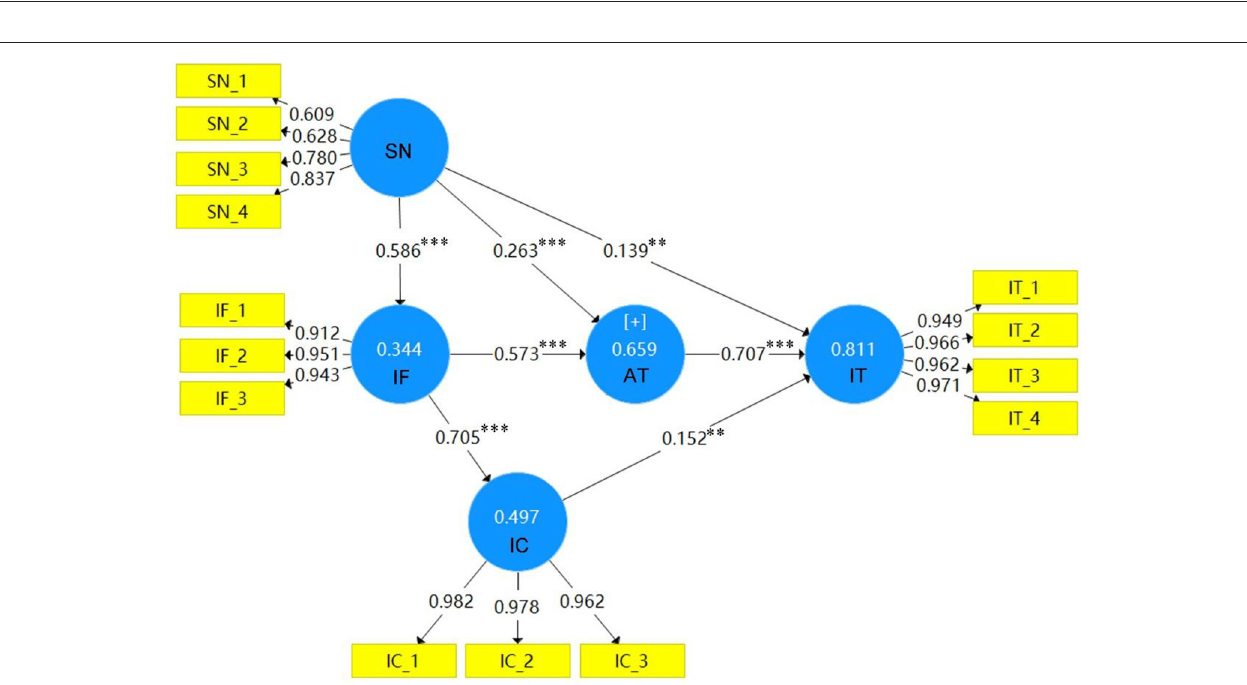
an individual is with wearing masks ( p = 0.041 < 0.05).